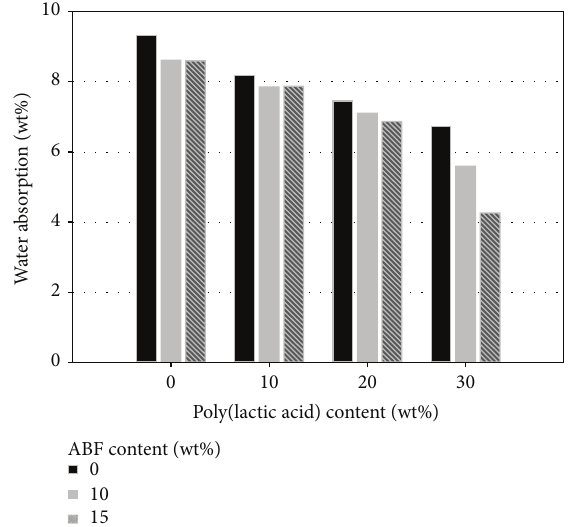
Figure 1: Moisture absorption of TPS/PLA/Fiber composites as a function of time for the polymer blend and composites containing 20 wt% PLA.